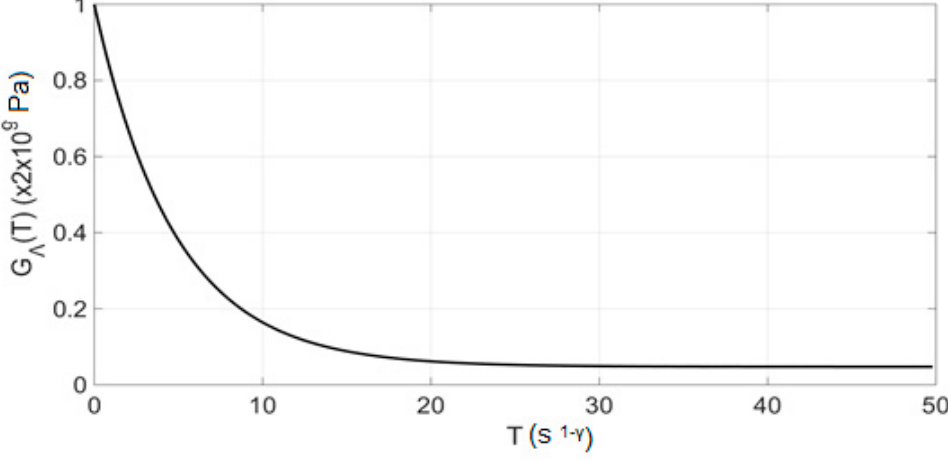
Figure 10. Variation of the relaxation modulus versus time in Λ -Space.